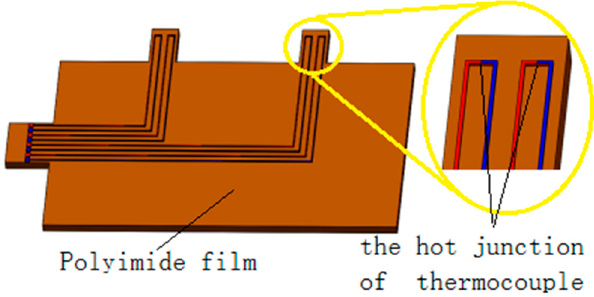
Figure 1. Physical model of the flexible thermocouple film sensor.